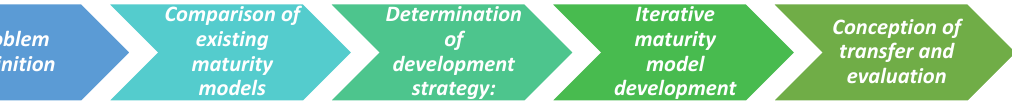
Figure 3. Phases for the development of maturity models proposed by Becker et al. (2009) [24].